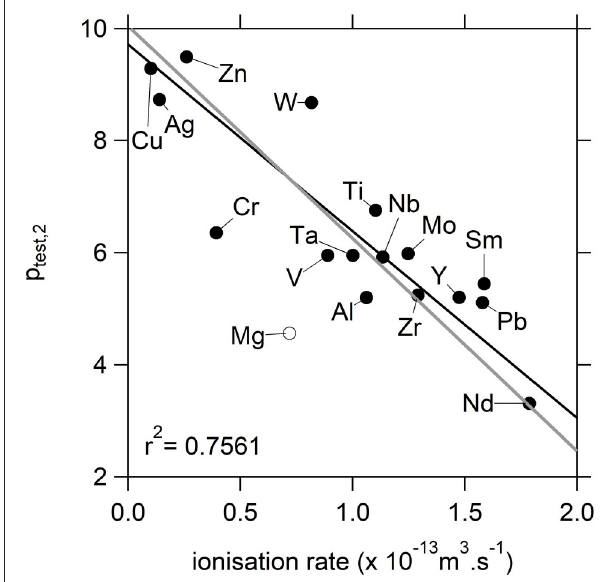
FIGURE 4 | he natural logarithm of the peak current as function of the total momentum transfer divided by the ion induced yield of the target material. The definition of p test,1 is given by Equation (4). The line is a fit through the data points, excluding the value of Pb (open marker). The gray line is a linear fit through the data, excluding the values of Ag, Cu, Pb, and Zn. The horizontal striped line is the peak power density limit for DCMS as defined by Gudmundsson et al. [31].